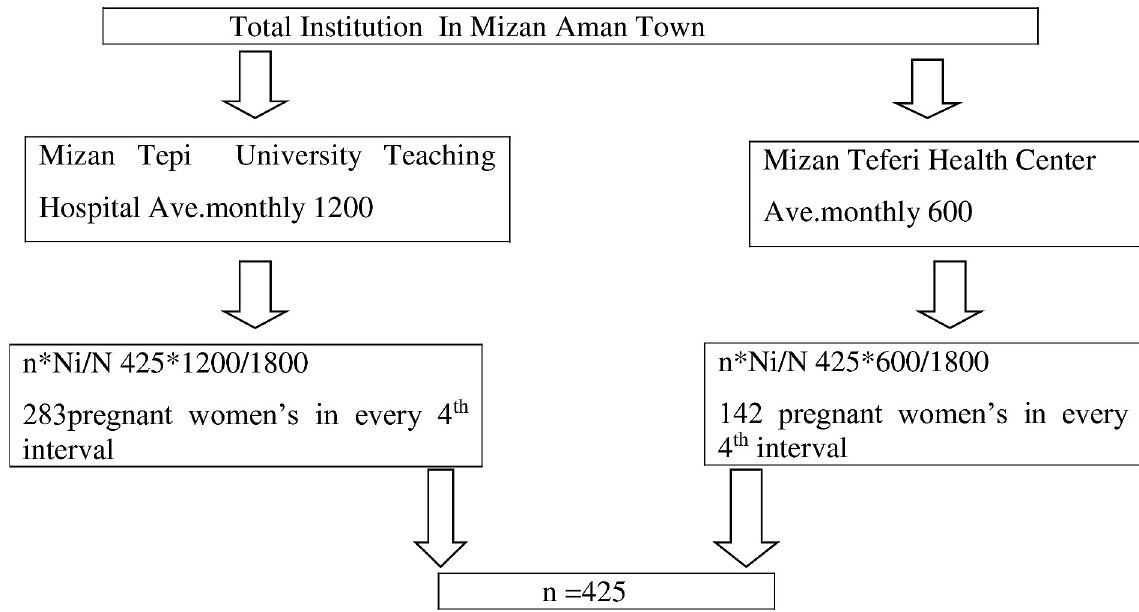
Fig 1. Schematic representation of sampling techniques on timing of first ANC booking and associated factors among pregnant women in Mizan-Aman town, southwest Ethiopia 2021.